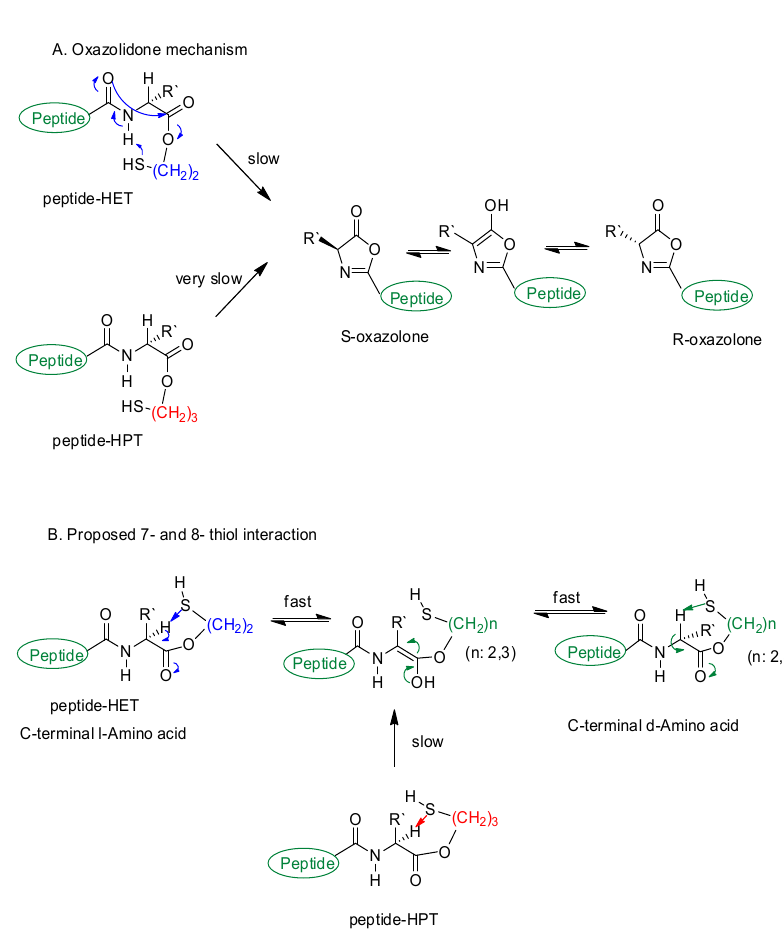
Scheme 3. Proposed racemization pathways at C-terminal residue. ( A ) is oxazolidone mechanism and ( B ) is proposed mechanism.